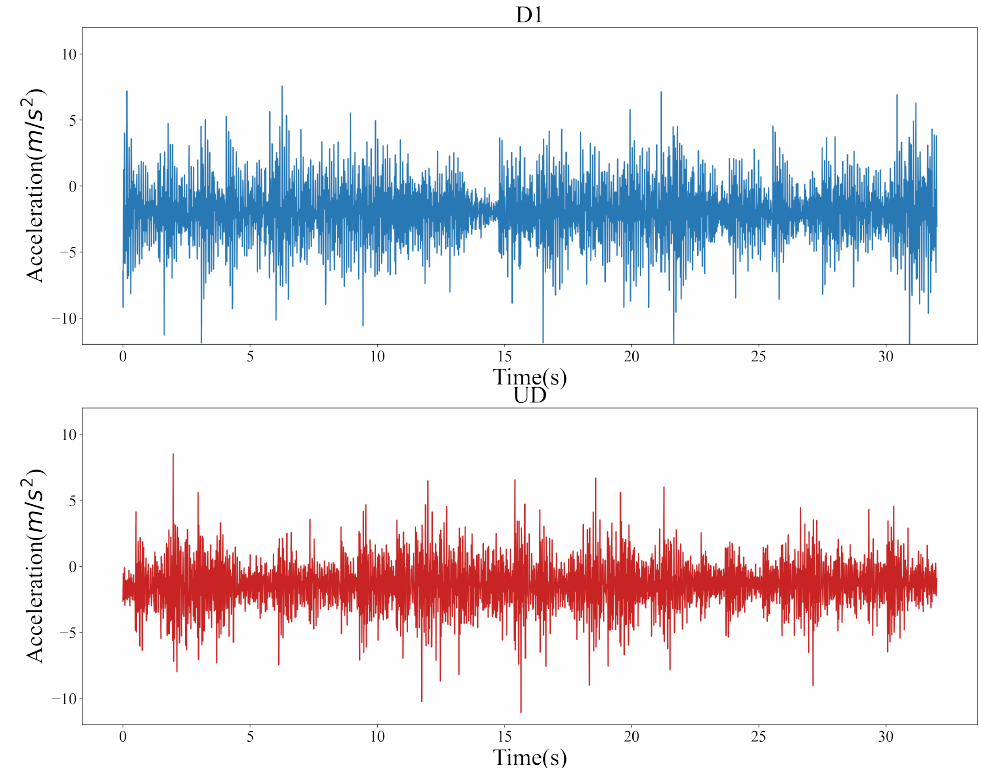
Figure 4. Examples of two kinds of damage